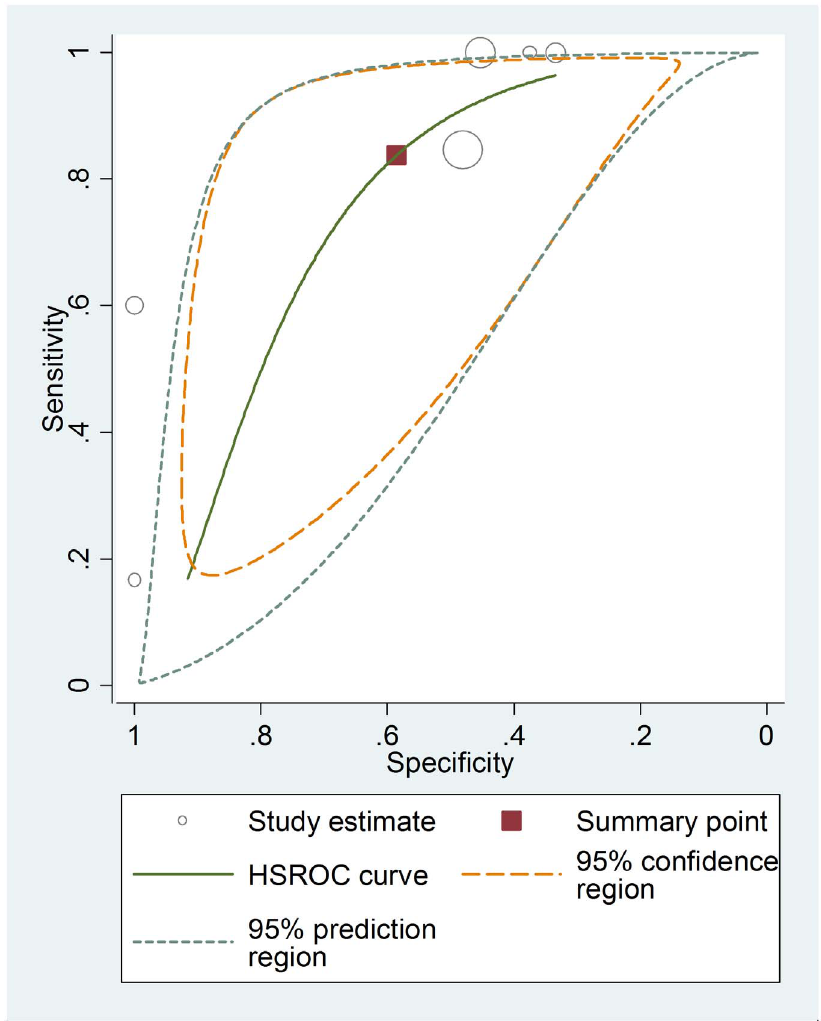
Figure 11. The hierarchical summary receiver operating characteristic (HSROC) curves of NSE to predict mortality in patients with traumatic brain